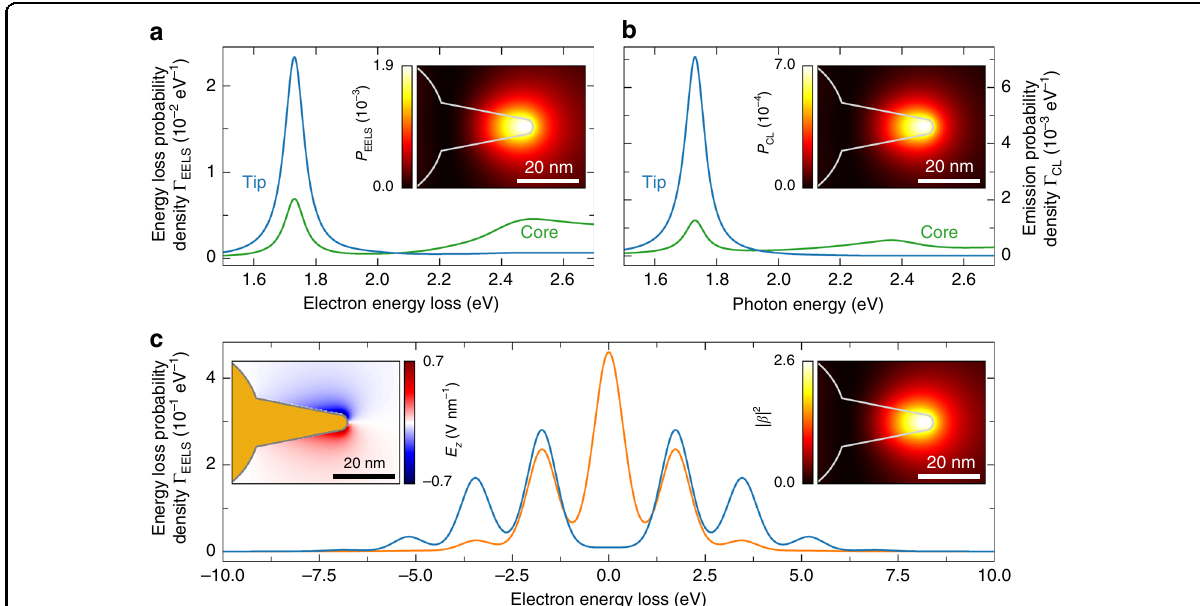
Fig. 4 Numerical BEM calculations. BEM calculations of a 200 keV EELS and b 20 keV CL spectra for electrons passing through the center of the spherical core (green) and 3 nm away from the tip apex (blue). The insets show EELS and CL probability distributions obtained for a spectral bandwidth of ±25 meV around the tip resonance at 1.73 eV. c Calculated 200 keV PINEM spectra for electrons with an energy spread of 0.9 eV passing 3 nm (blue) and 20 nm (orange) away from the tip apex (plane wave pump fi eld incident along z and polarized along x , (cid:1) h ω L = 1.73 eV photon energy, and 0.02 GW cm − 2 intensity). The left inset shows a time snapshot of the z component of the optically induced near fi eld in the x – z -symmetry plane of the tip; the right inset shows a x – y map of the calculated squared electron – photon coupling strength β j j